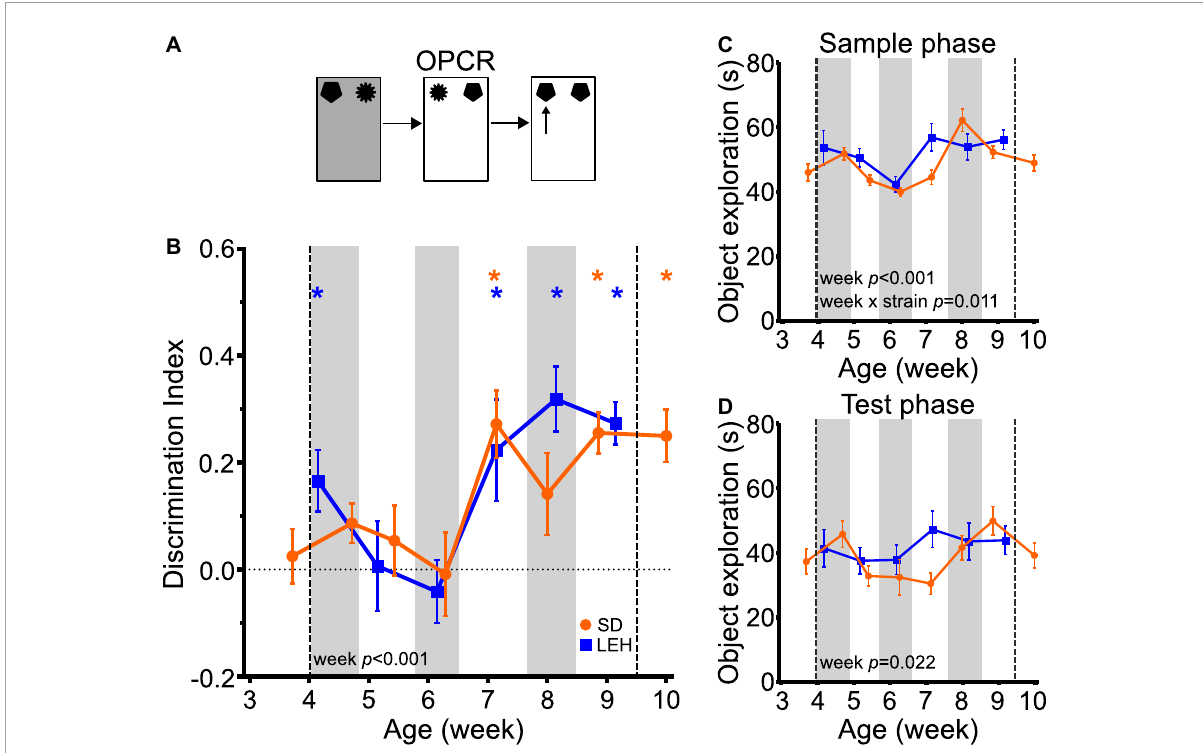
FIGURE5 Object-place-context recognition memory emerges at around 7 weeks of age in LEH and SD rats. (A) Schematic of object-place-context recognition task; (B) Object-place-context recognition memory performance, expressed as discrimination index across development. Both LEH and SD rats show significant memory consistently from the 7th week of age (P50 for both LEH and SD), although LEH rats also show significant memory at 4 weeks of age (P39) before performing at chance on weeks five and six. * p < 0.05. A significant main effect of week was found; (C) Object exploration during the sample phases (mean of the two sample phases) for each testing time point for both LEH and SD rats. A significant main effect of week and a significant week × strain interaction were detected for mean object exploration during the sample phases; (D) Object exploration during the test phase. No significant main effects or interactions were detected. [SD]: n = 16 except P38&P50 where n = 15; [LEH]: n = 13 except P43&P57 where n = 12. For details on sample sizes, t , and p -values for one-sample t -tests, see Supplementary Table 2 . Asterisks, shading on graphs etc., follow same convention as Figure 2 .